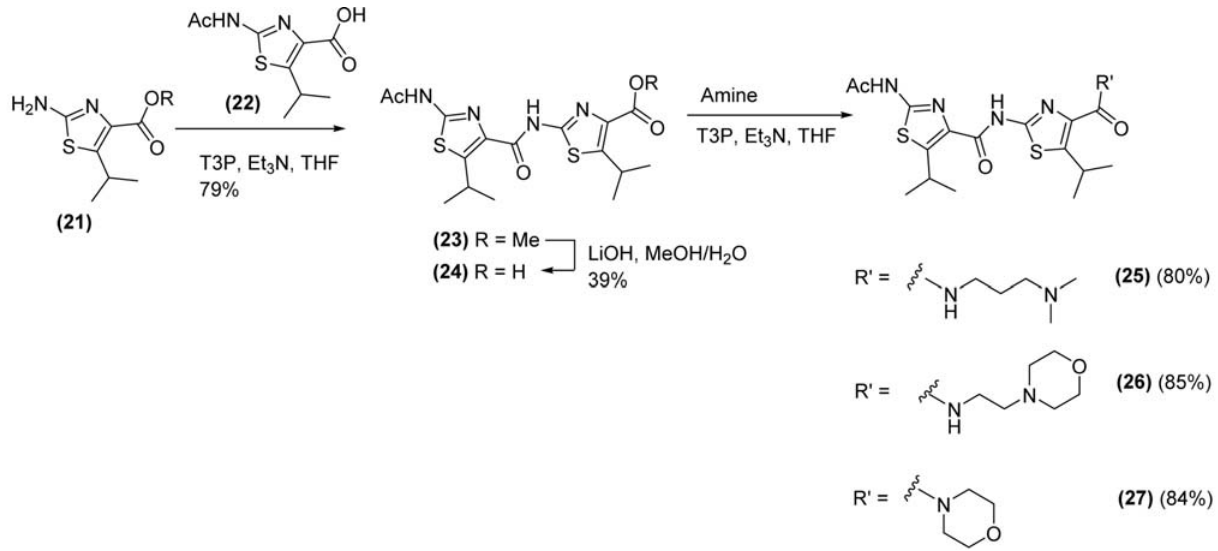
Scheme 6. Synthesis of C-isopropyl-substituted thiazole amide